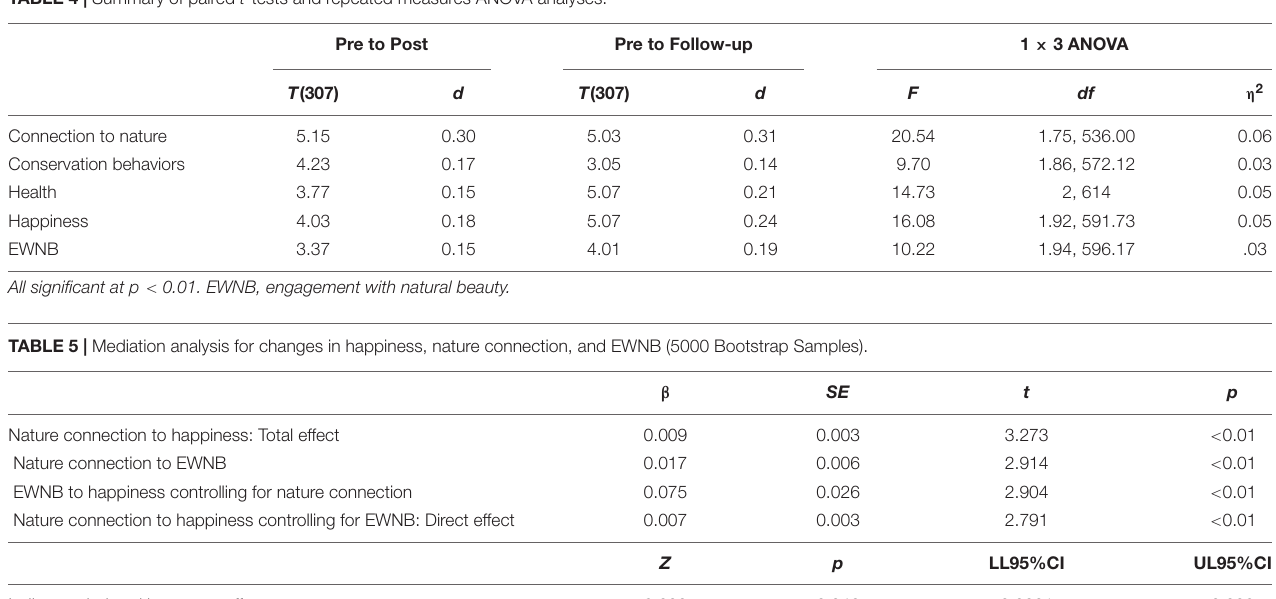
TABLE 4 | Summary of paired t -tests and repeated measures ANOVA analyses.